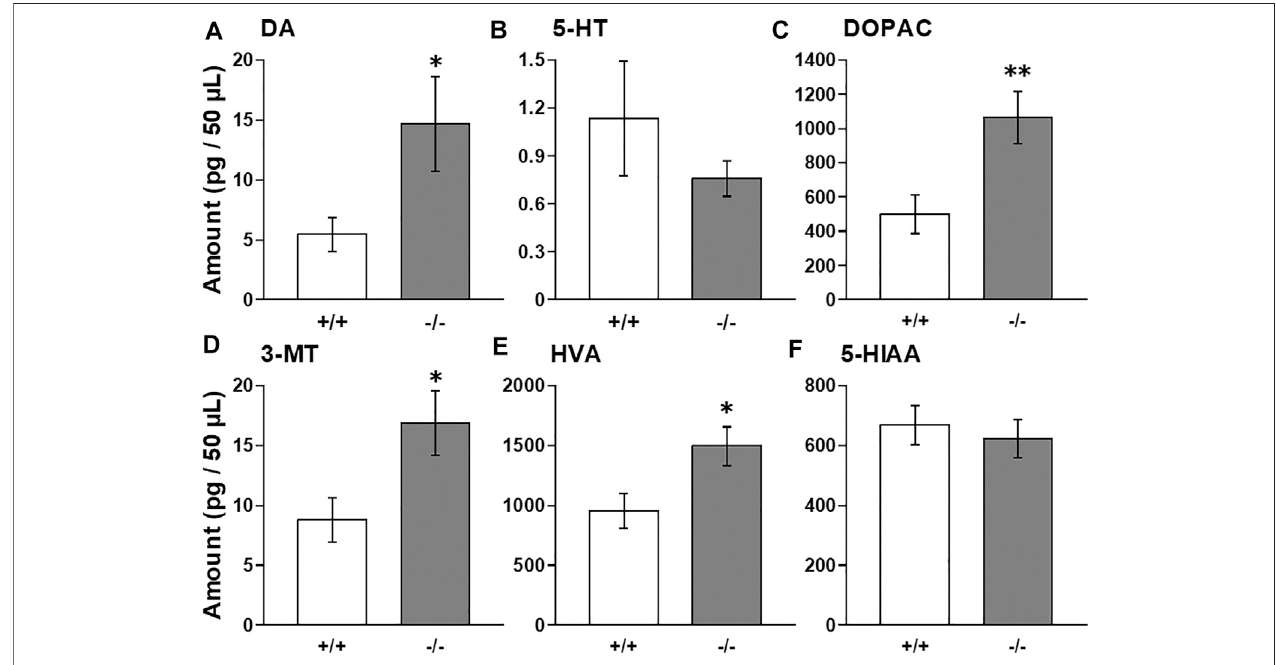
FIGURE 1 | Basal extracellular DA, 5-HT, and their metabolites levels in the striatum in awake FFAR1+/+ and − / − mice. FFAR1 − / − mice showed signi fi cantly elevatedbasalDAlevel (A) .AllmetabolitesofDA,DOPAC (C) ,3-MT (D), andHVA (E) alsoshowedsigni fi cantlyincreasedlevelsin − / − mice.Meanbaseline5-HTlevel (B) wassubstantiallyreducedin − / − mice,butthoseof5-HTmetabolite,5-HIAA (F) ,didnotdiffersigni fi cantlybetweenthetwogenotypes.* p < 0.05,** p < 0.01vs.+/+mice (Student ’ s t -test). n (cid:2) 17 for +/+ mice, and n (cid:2) 16 for − / − mice.